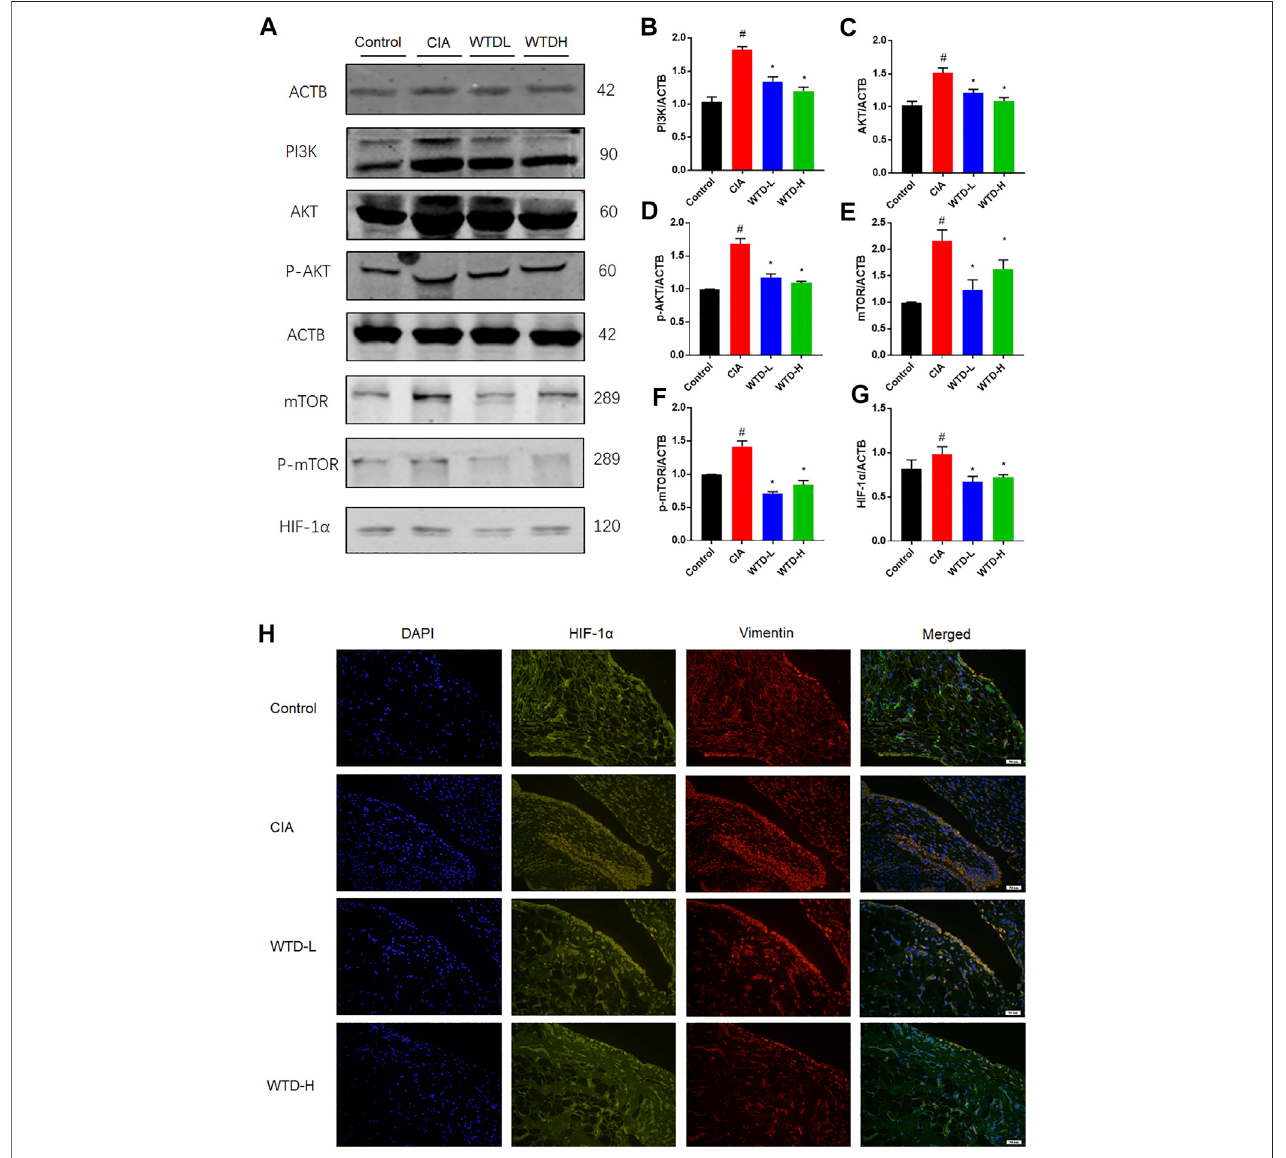
FIGURE 7 | The effects of WTD on the PI3K-AKT-mTOR-HIF-1 α pathway in vivo . (A) Representative western blots showing the components of the PI3K-AKT- mTOR-HIF-1 α pathway after WTD treatment in CIA rats. (B – G) Quantitative analysis of the western blots after WTD treatment in CIA rats. (H) Representative immuno fl uorescencestainingforHIF1 α inthesynoviumofCIArats. Theresultsareexpressed asmean ± SE. N (cid:2) 6.# p < 0.05, ## p < 0.01versusthecontrolgroup;* p < 0.05, ** p < 0.01 versus the CIA group. CIA, The Collagen-induced arthritis group; WTD-L, the low dose Wutou decoction group (3.75 g/kg/day); WTD-H, the high dose Wutou decoction group (7.5 g/kg/day). ACTB, β -actin; PI3K, Phosphatidylinositide 3-kinases; AKT, protein kinase B; p-AKT, Phosphorylated protein kinase B; mTOR, Mammalian target of rapamycin; p-mTOR, Phosphorylated Mammalian target of rapamycin; HIF-1 α , Hypoxia-induced factor 1 α .